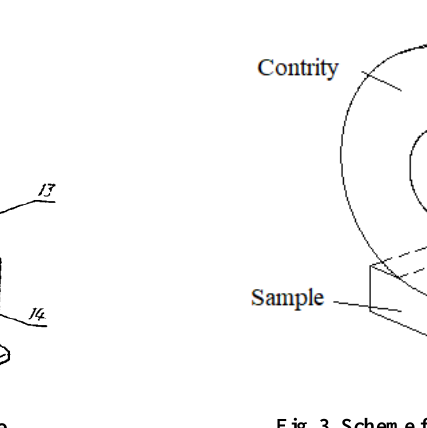
Fig. 2. Scheme of friction nod e Fig. 3. Scheme friction shaft-plane